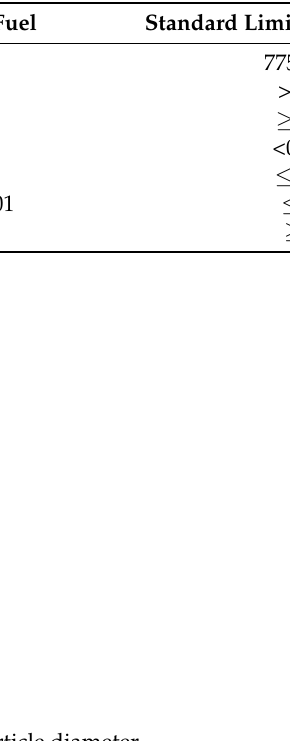
Table 1. Physical properties of fuels at 20 °C.